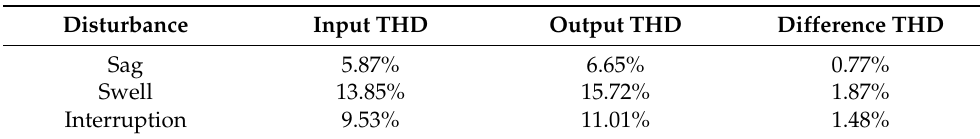
Table 3. Difference between the THDs of input and output signals for sag, swell and interruption disturbances, representing the distortion introduced by the proposed